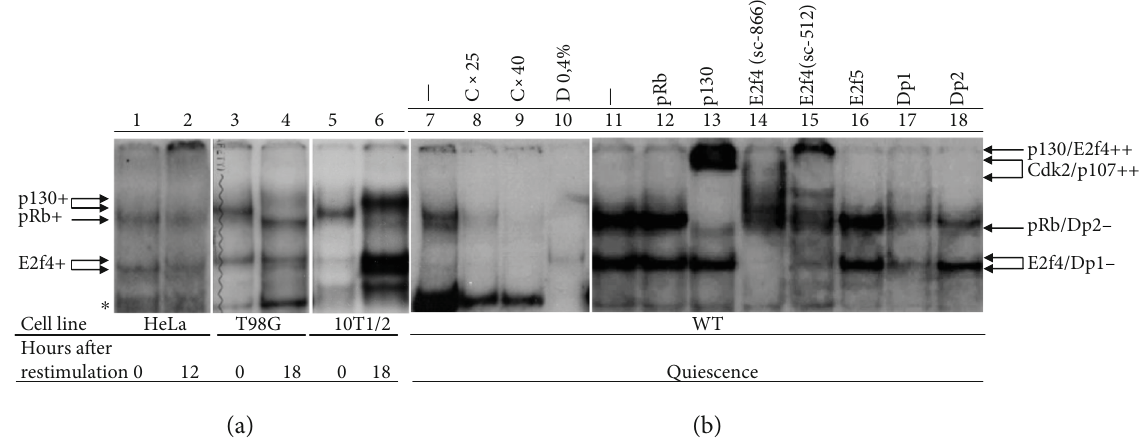
Figure 4: The structure of the pp-E2f-DNA complexes in quiescent 10T1/2 cells. (a) The pp-E2f4-DNA complexes in the quiescent and cycling T98G, 10T1/2, and HeLa cell lines. (b) Analysis of protein structure of the pp-E2f-DNA complexes in the quiescent 10T1/2 cells. The cells were synchronized as described above. The abbreviations are the same as in Figure